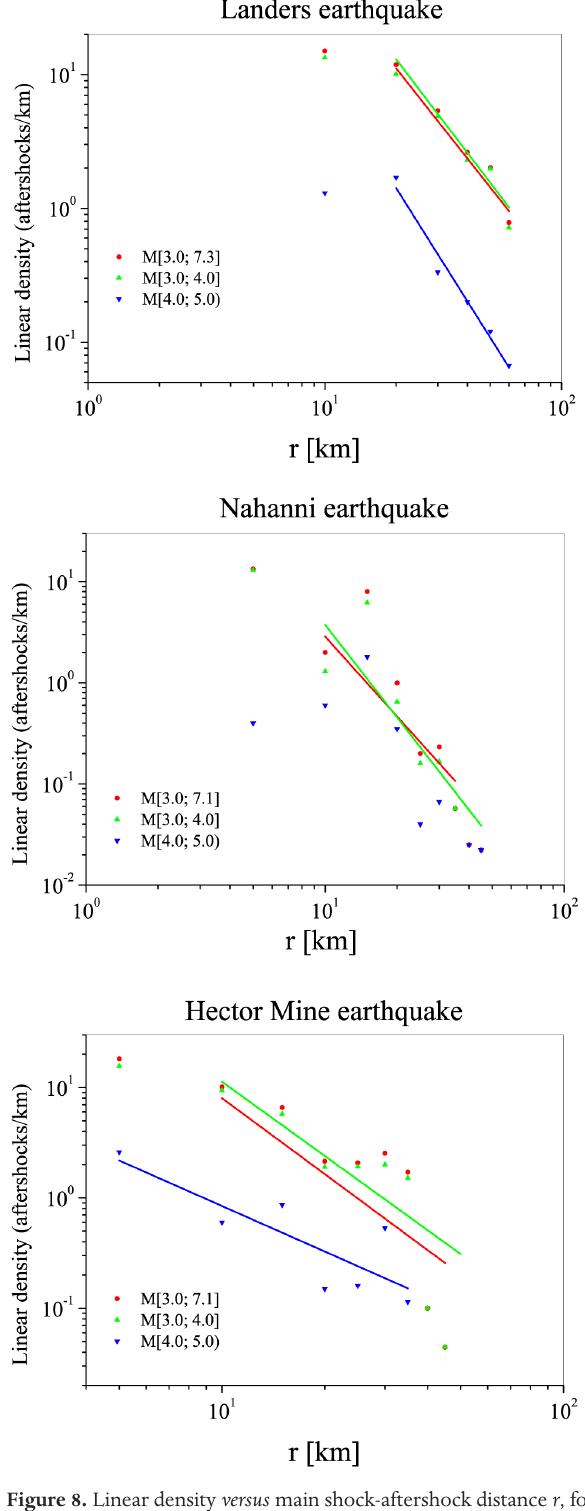
Figure 8. Linear density versus main shock-aftershock distance r , for the selected earthquakes in various magnitude